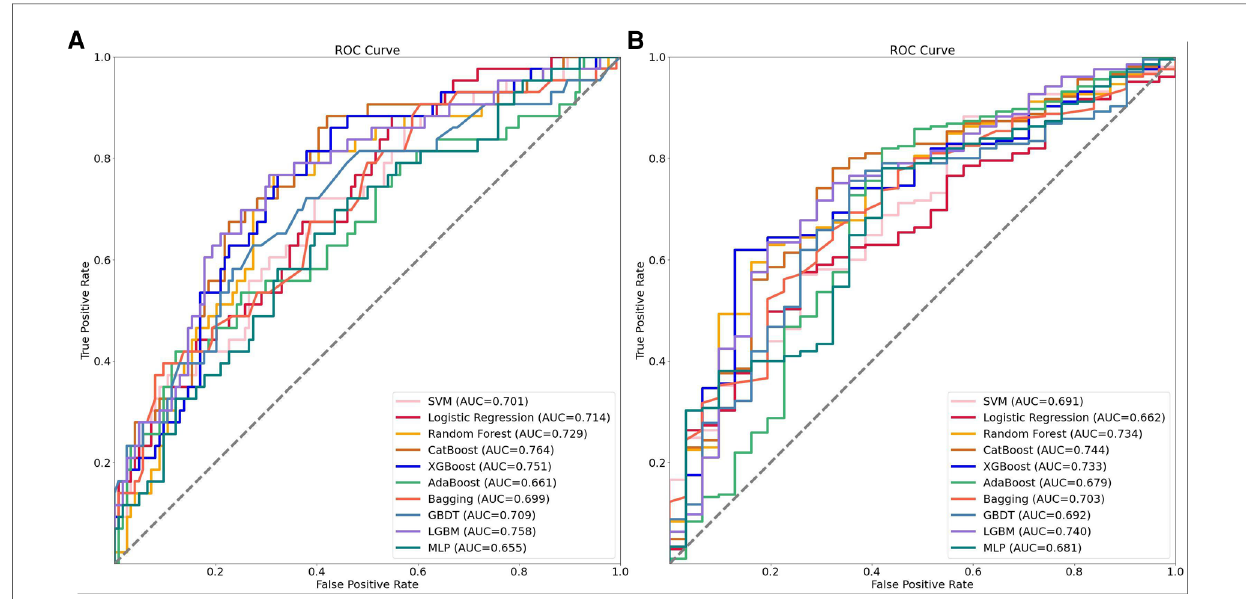
FIGURE 2 The receiver operating characteristic (ROC) curves of the 10 machine learning models established in the two groups. Panel A shows the ROC curves for the CMP-IV group, while Panel B shows the ROC curves for the No CMP-IV group. The acronyms in the legend stand for the following: SVM, support vector machine; Catboost, categorical boosting; XGBoost, extreme gradient boosting; AdaBoost, adaptive boosting; Bagging, bootstrapped aggregation; GBDT, gradient boosting decision trees; LightGBM, light gradient boosting machine; MLP, multilayer perceptron.